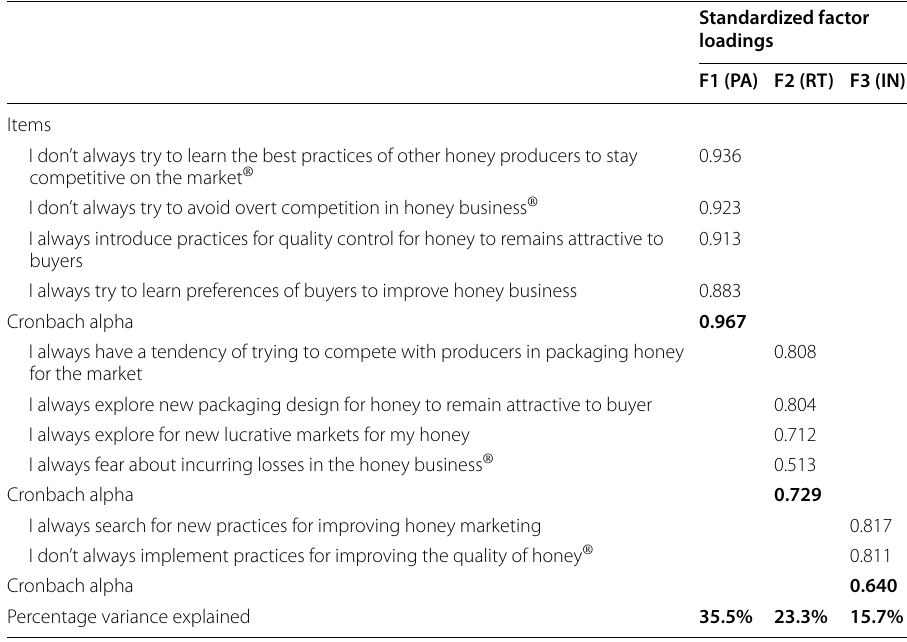
The bold figures are for the cronbach Alpha values of the major Factor loadings Total variance explained innovativeness (IN)